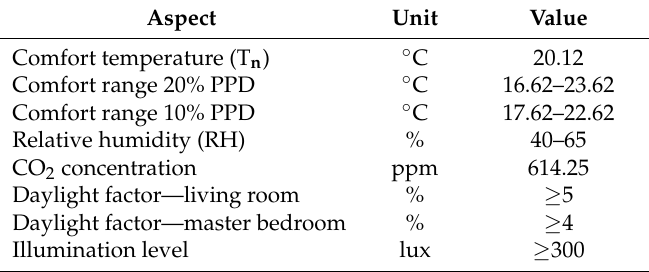
Table 6. Summary of established comfort standards for urban houses in